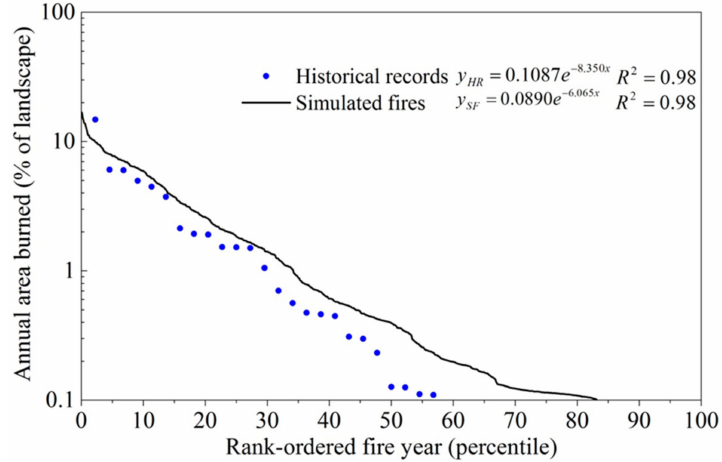
Figure 4. The rank-ordered distributions of the percent area of the landscape burned in the 44 years of historical fire records for Wood Buffalo National Park (WBNP) and the 1200 years of simulated data, and their exponential regression parameters. The y-axis is truncated at 0.1% as simulated data with fire-years lower than that all had zero area